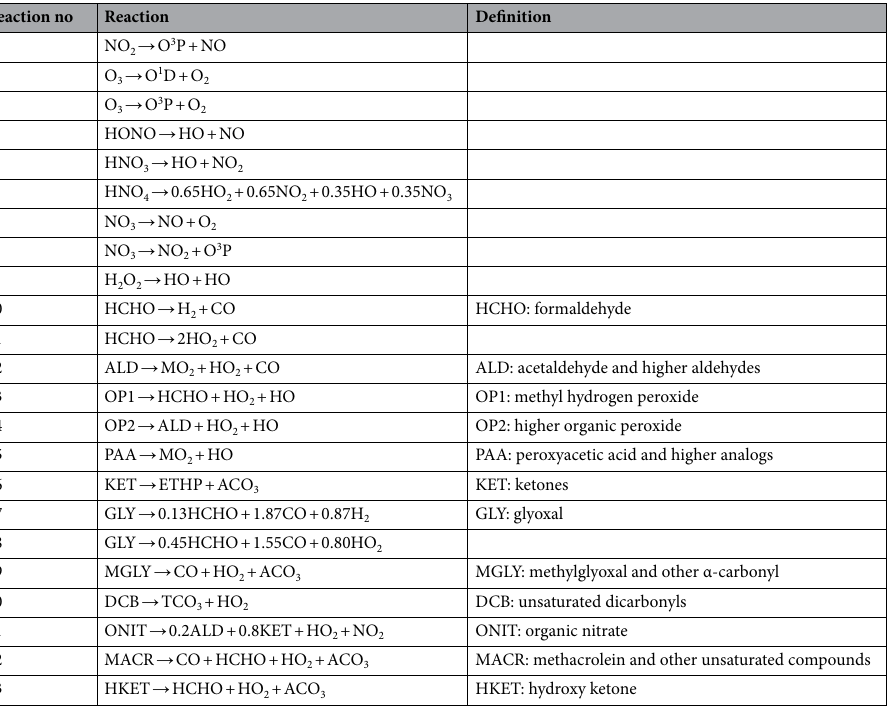
Table 2. RACM 23 photolysis